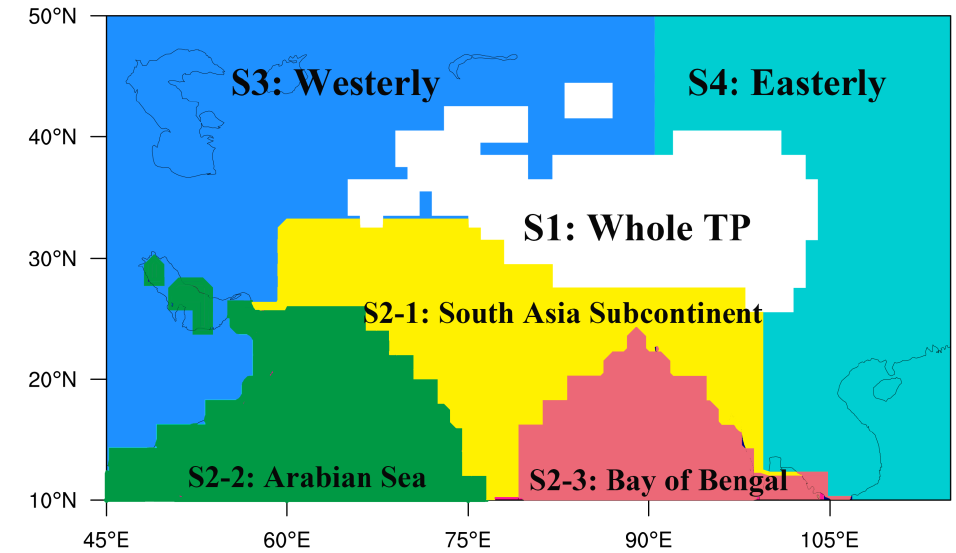
Figure 2. Tracked moisture source regions. S1: Whole Tibetan Plateau with an elevation higher than 2500 m; S2: South Asian monsoon region including South Asia subcontinent, Arabian Sea, and Bay of Bengal; S3: West region of 90°E and regions of S1 and S2 are taken out; S4: East region of 90°E and regions of S1 and S2 are taken out.